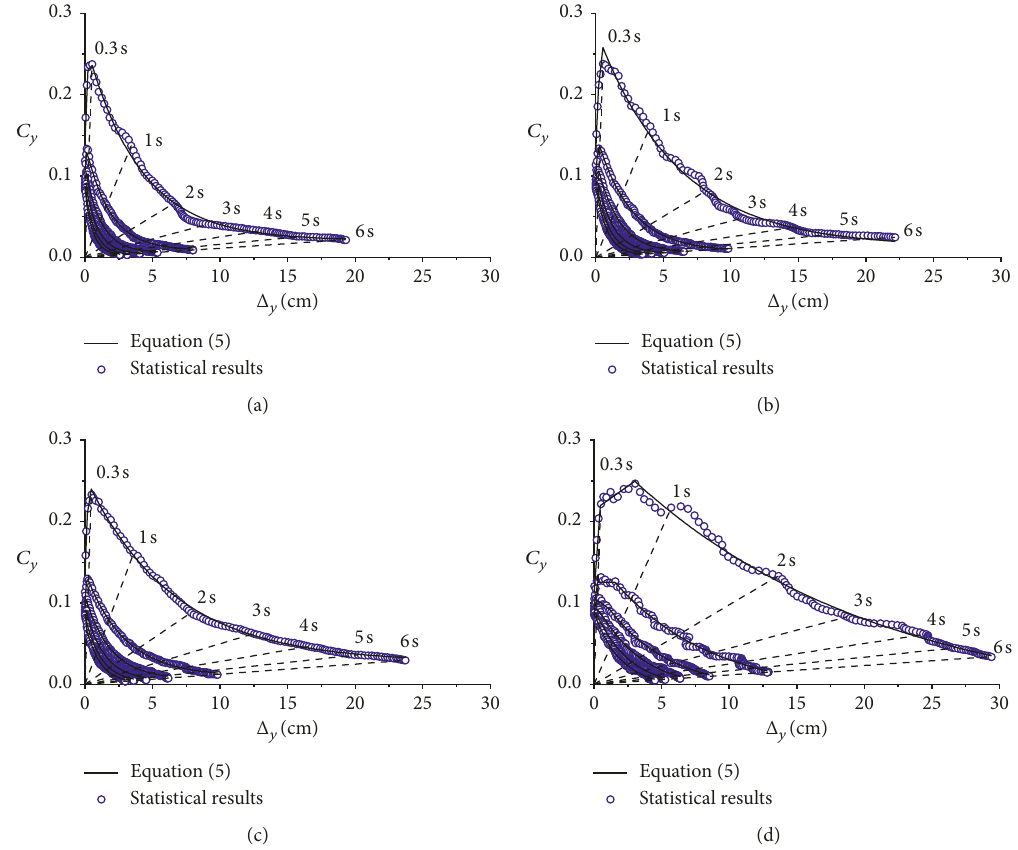
Figure 13: Comparisons of the results predicted by equation (5) and the analytical results considering four soil sites: (a) site B; (b) site C; (c) site D; (d) site